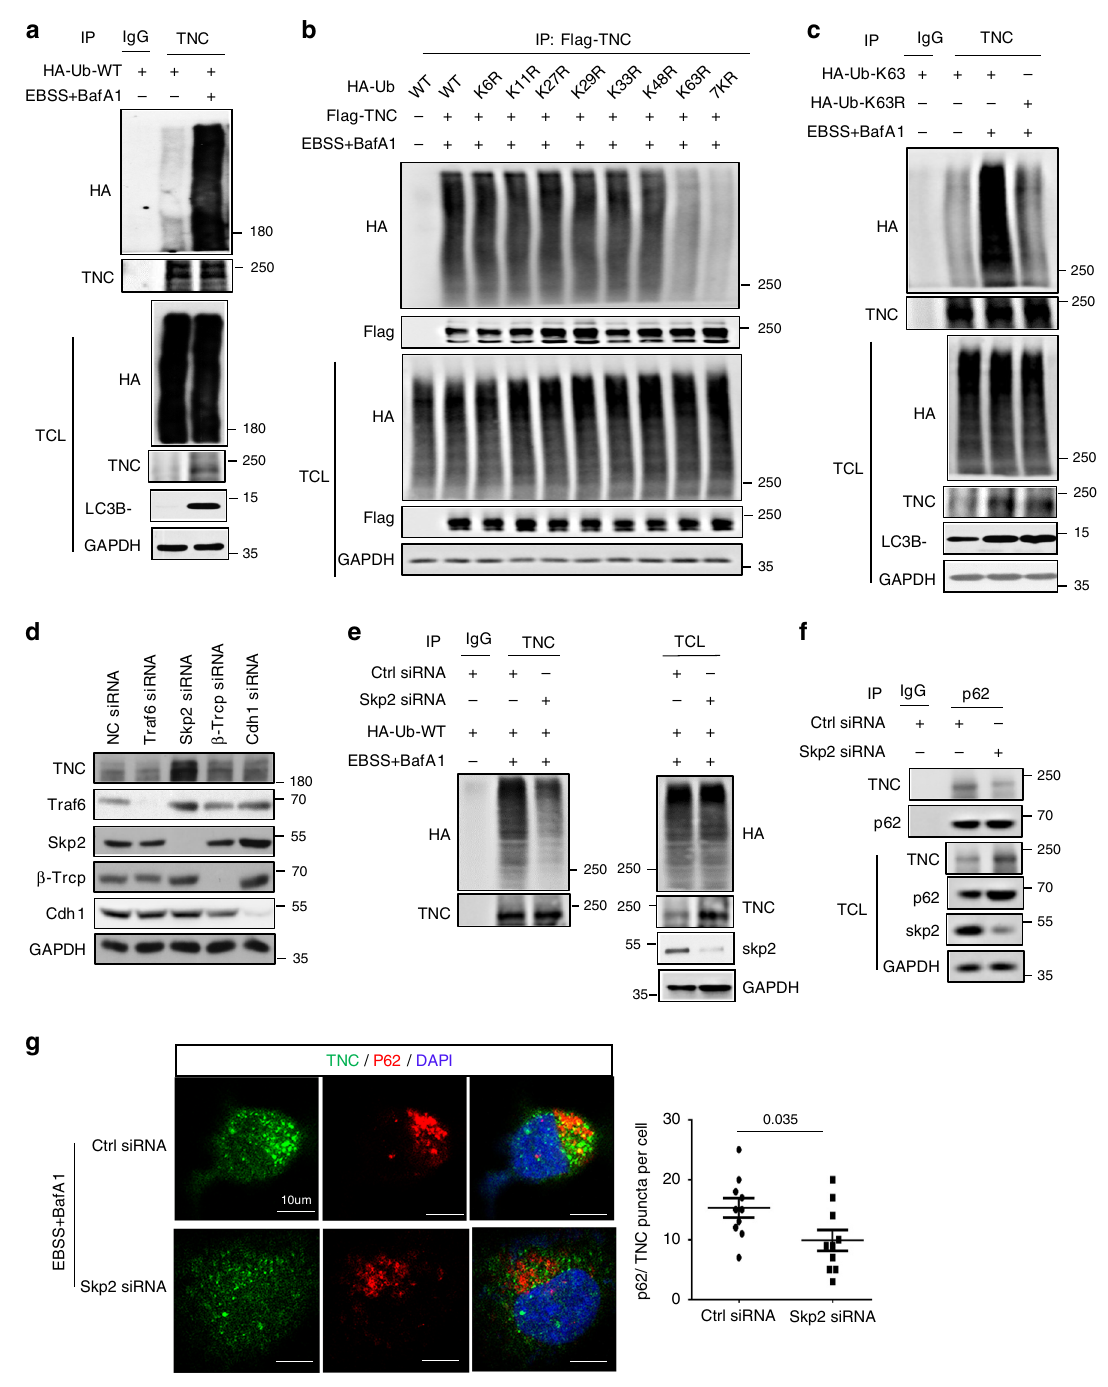
Fig. 5 Skp2 mediates autophagic degradation of TNC. a Coimmunoprecipitation and immunoassay of extracts of HEK293T cells treated with EBSS in the presence of BafA1 for 2 h. b HEK293T cells were transfected with Flag-tagged TNC and HA-tagged wild-type Ub (WT) or ubiquitin mutants (K6R, K11R, K27R, K29R, K33R, K48R, K63R, 7KR) and treated with EBSS in the presence of BafA1 for 2 h, followed by immunoprecipitation with anti-Flag beads and immunoblot analysis with anti-HA. c Coimmunoprecipitation and immunoassay of extracts of HEK293T cells transfected with various combinations of plasmid, then treated with or without EBSS in the presence of BafA1 for 2 h. d Immunoblot analysis of MDA-MB-231 cells transfected with the indicated siRNA oligonucleotides for 48 h. e HEK293T cells were transiently transfected with Skp2 siRNA for 12 h, then co-transfected with HA-Ub-WT for another 48 h. Then the cells were treated with EBSS treatment in the presence of BafA1 for 2 h. f HEK293T cells were transiently transfected with Skp2 siRNA for 48 h, p62 proteins were immunoprecipitated and the bound TNC proteins examined by immunoblot. g Confocal microscopy of MDA-MB-231 cells treated with Skp2 siRNA in the presence of EBSS for 2 h along with BafA1 (left). Scar bar, 10 µ m. Statistics of the puncta formation by TNC-p62 were determined in the indicated samples ( n = 10 cells per group, right). Error bars represent mean ± SEM. The P value in g was determined by a two-tailed unpaired Student ’ s t test. All data are representative of three independent